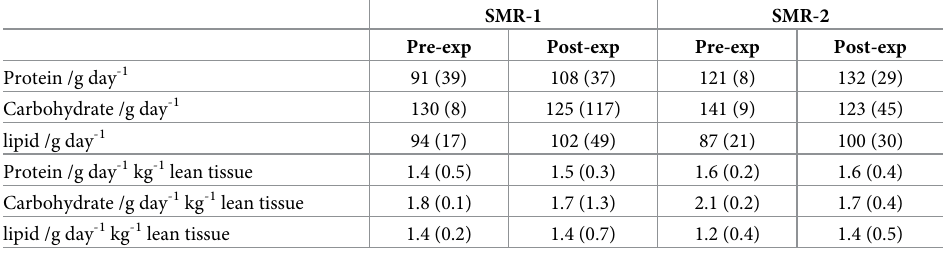
Table 3. Average [median (IQR)] substrate utilisation pre- and post-expedition for the energy expenditure during the two periods of sleep, SMR-1 and SMR-; raw and normalised to lean tissue